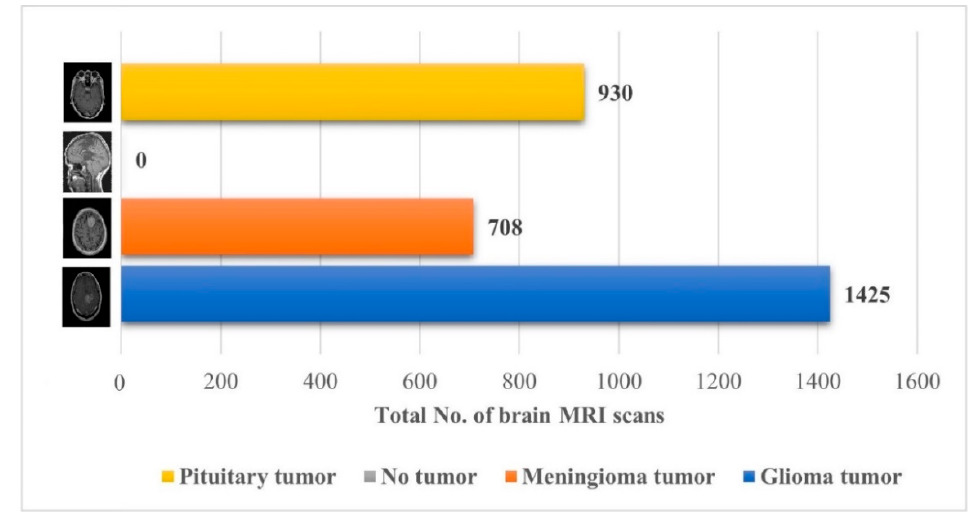
Figure 7. Details about the unseen brain MRI dataset used for testing the proposed model [38] .